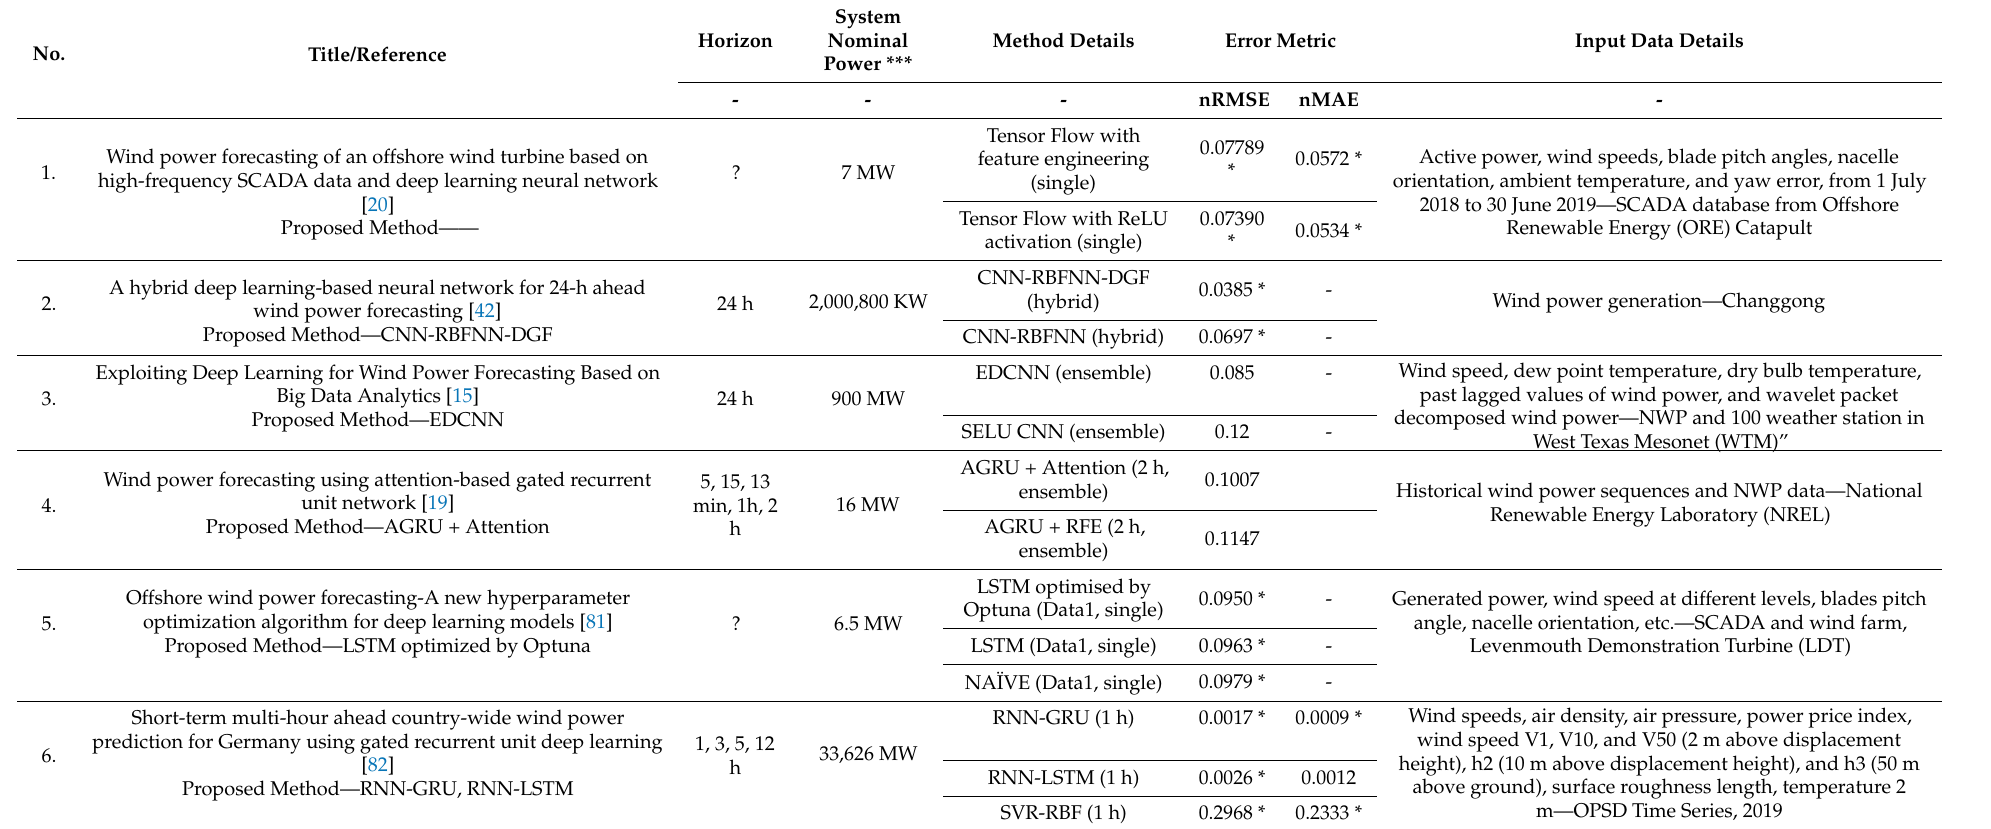
Table 6. Summary of errors obtained for offshore wind power forecasting